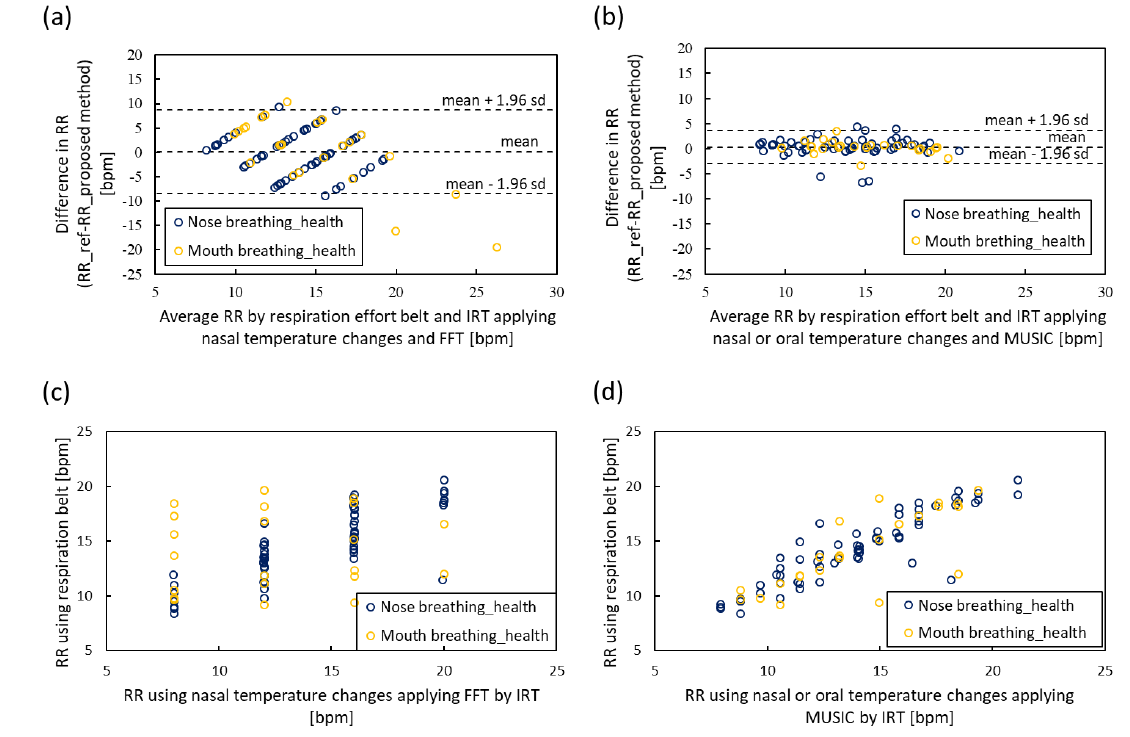
Figure 9. Bland–Altman plots and scatter plots of RR obtained by infrared thermography (IRT) sensor and respiratory effort belt. ( a ) Bland–Altman plot of nasal temperature change under the application of FFT. ( b ) Bland–Altman plot of the proposed method applying nasal or oral signal selection using SQI and MUSIC. ( c ) Scatter plot of nasal temperature change under FFT application. ( d ) Scatter plot of the proposed method.